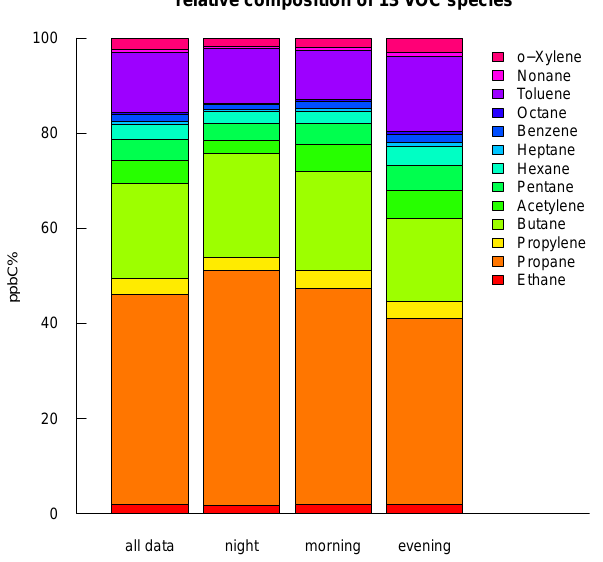
Fig. 1. Relative composition of 13 VOC species in ppbC for all data